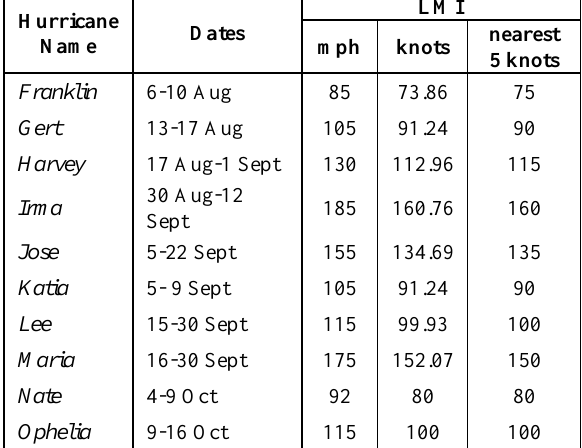
2 . List of Atlantic hurricanes in 2017 stated in NOAA’s monthly Atlantic tropical report.